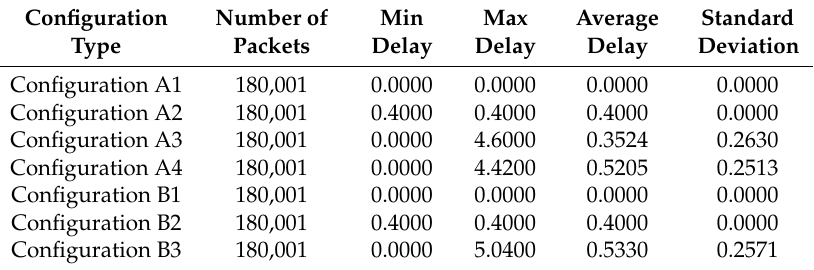
Figure 10. Speed response of fuel cell powertrain system under different configurations.